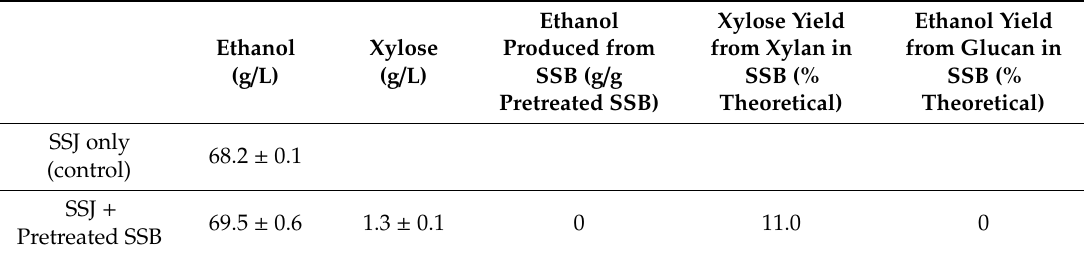
Table 4. Results of ethanol fermentation using untreated SSB in